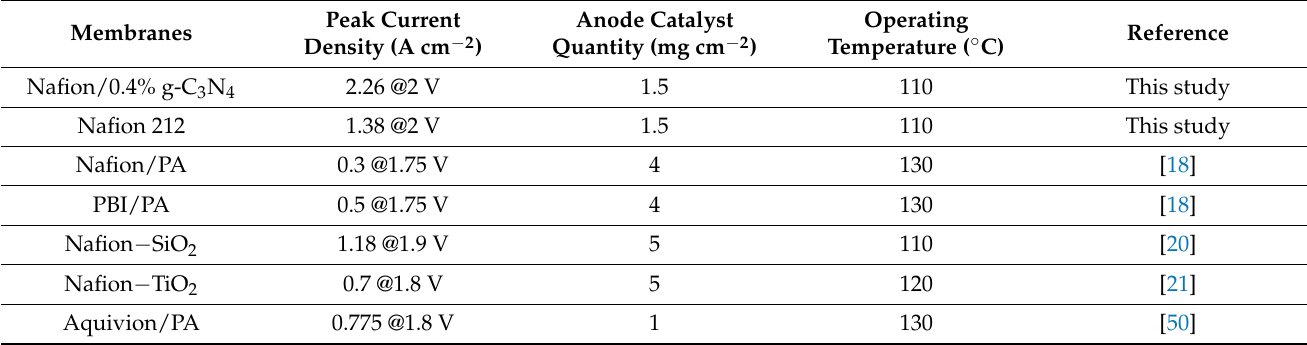
Table 2. Comparison of the steam electrolysis performance of various membrane